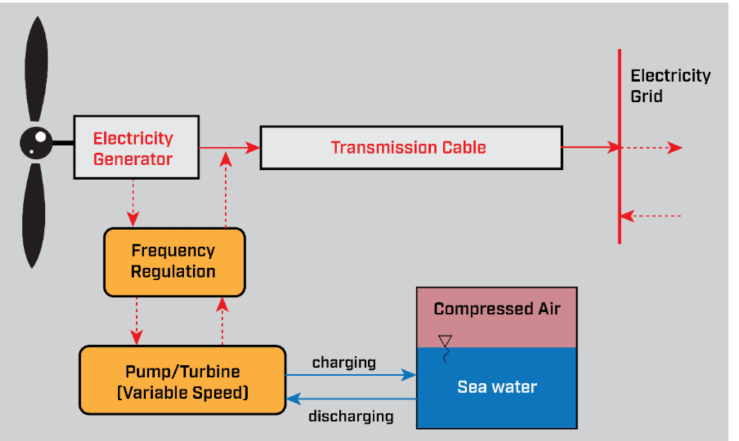
Figure 3. Operating principle of a wind-turbine-integrated hydro-pneumatic energy storage concept. (Modified from Sant et al.